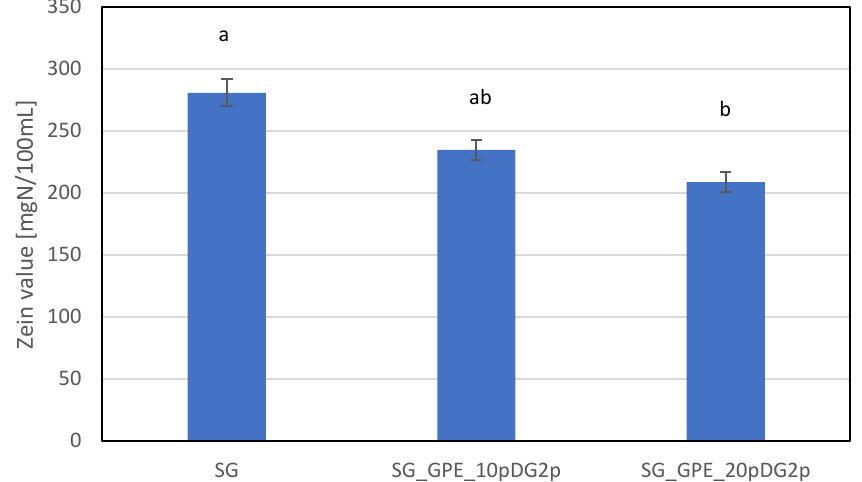
Figure 5. The irritant potential of model bodywash gels. The superscripts a and b denote significant ( p < 0.05) differences between the test extracts.